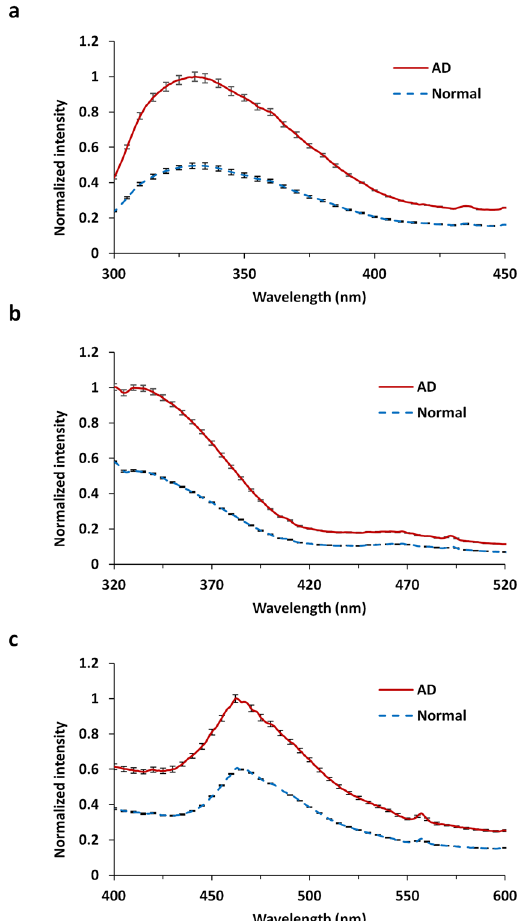
Figure 1. Averaged spectral (emission) profiles with error bar (n = 5) of AD and N brains at excitation wavelength ( a ) 266 nm, ( b ) 300 nm, and ( c ) 340